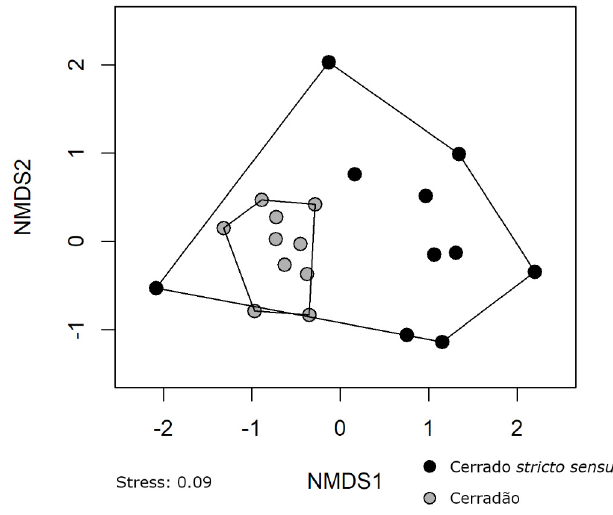
Fig 2 . Ant species composition present in two adjacent cerrado areas. Each dot represents a sample spot (food bait). The ant species composition formed two distinct groups according to the cerrado area (ANOSIM: R = 0.53, p =